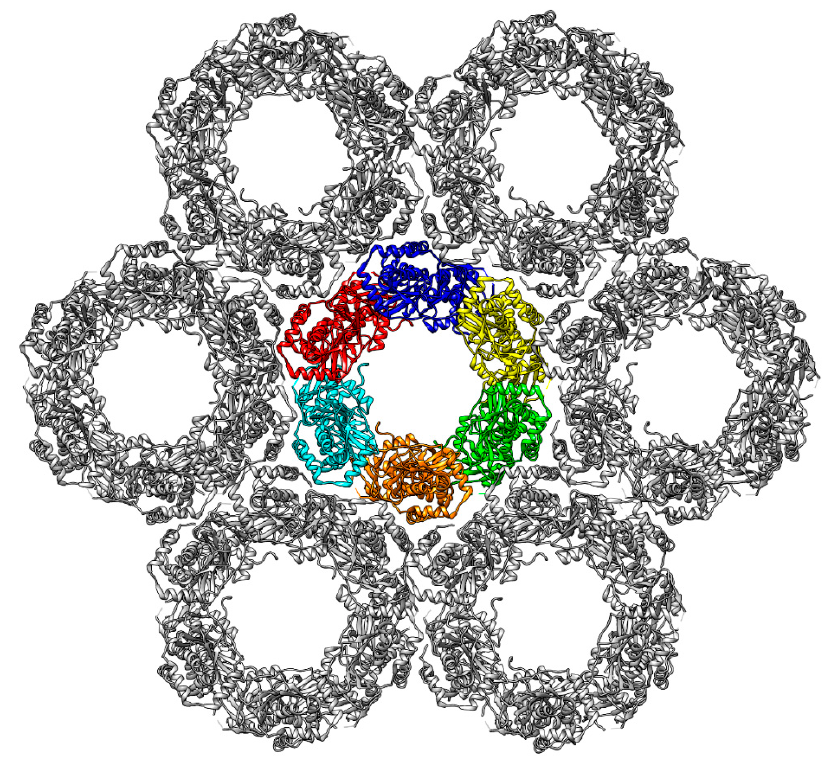
Figure 2. Structure of the PRV hexagonal lattice derived from a cryo-EM (cryo-electron microscopy) study [23]. In the central Hexagon, each of the six heterodimers is coloured individually (blue, yellow, green, orange, cyan, and red). Each Hexagon is surrounded by six additional Hexagons (grey), thereby forming large lattice-like structures.